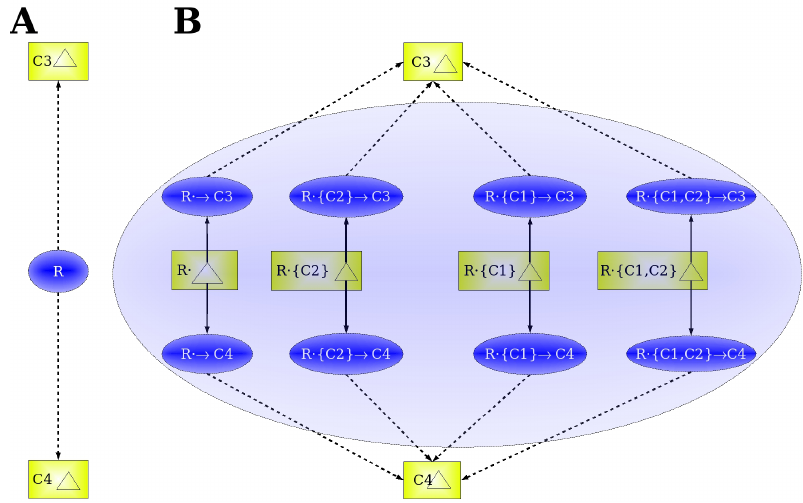
Figure 5: Example of a regulatory site demultiplication with two regulated species (and the same regulating species as in Figure 4; only IRC are illustrated (except in the gray